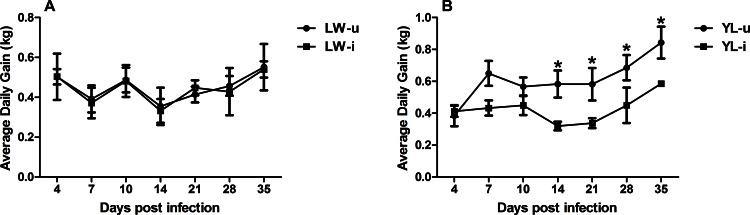
Changes in average daily gain after PCV2 infection.The average daily gain of LW-u pigs (A), LW-i pigs (A), YL-u pigs (B) and YL-i pigs (B) were collected at different dpi. The average daily gain of YL-i pigs decreased from 14 dpi compared with YL-u pigs. * P < 0.05 versus YL-i group at the same dpi.